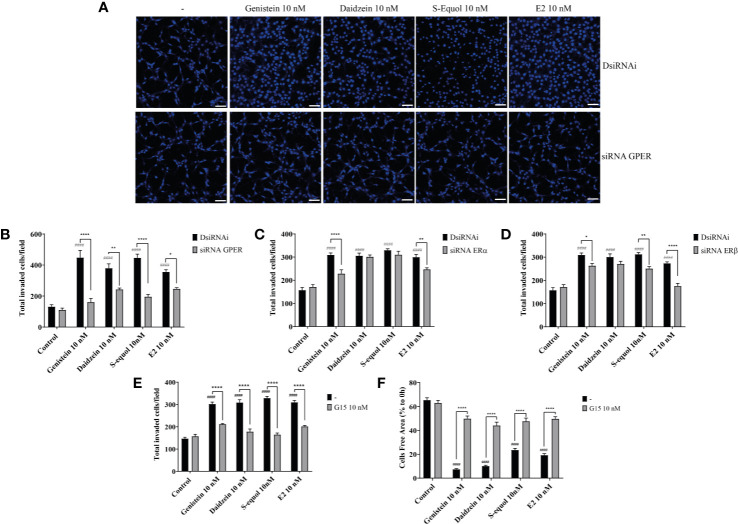
Isoflavones increased astrocyte migration via G-protein-coupled estrogen receptor (GPER) activation. Mouse primary cerebellar astrocytes were cultured for seven days prior to siRNA transfection, and matrigel invasion assay followed by DAPI staining was performed (A–D). (A) Representative photomicrographs showing the effects of isoflavones on cell migration after deletion of GPER. (B–D) Quantitative analysis of the effect of isoflavones on cell invasion after deletion of GPER (B), ERα (C), or ERβ (D). (E) Quantitative analysis of the effect of G15, a GPER inhibitor, on isoflavone-accelerated cell invasion using astrocytes. (F) Quantitative analysis of the effect of G15 on isoflavone-accelerated C6 cell migration. Bars represent 50 μm. Data are expressed as mean ± SEM (n = 15 determinations) and are representative of at least three independent experiments. ####
p < 0.0001, indicates statistical significance measured using Bonferroni’s test compared with the control. ****
p < 0.0001, **
p < 0.01, *
p < 0.05, indicates statistical significance measured using Bonferroni’s test.